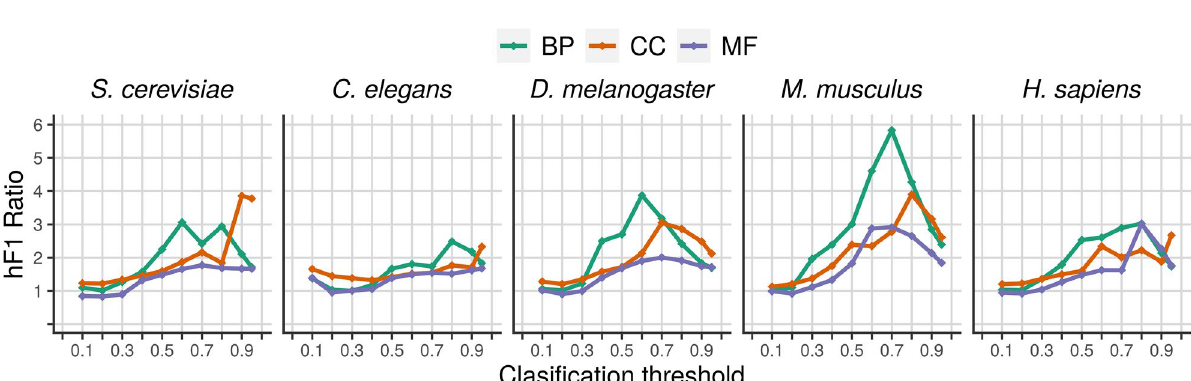
Figure 4. Ratio between the hF1 score of the trained model and the hF1 score of the corresponding random model as a function of the classification threshold. Each graph shows the results for a given ontology, representing each organism with a different color.